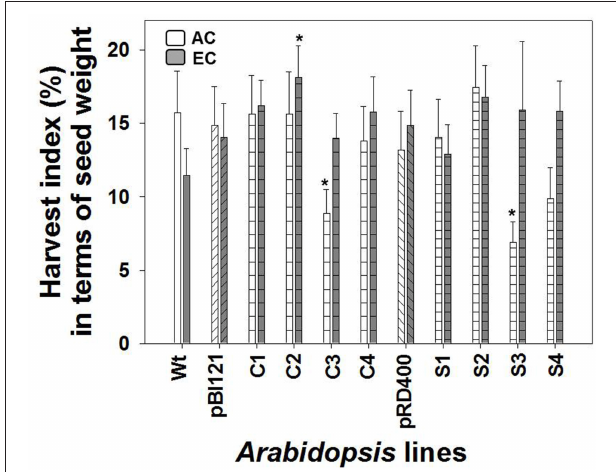
FIGURE 8 | Harvest index in Arabidopsis lines grown at either AC or EC. Harvest index in terms of seed production is presented. CO 2 treatments: 380 ppm (AC, white bars or open circles/dashed line), 700ppm (EC, gray bars or closed circles/solid line). Asterisks ( * ) indicate results significantly different from wild type (WT) at α = 0.05. Values represent the mean ± SE; n = 10 plants per